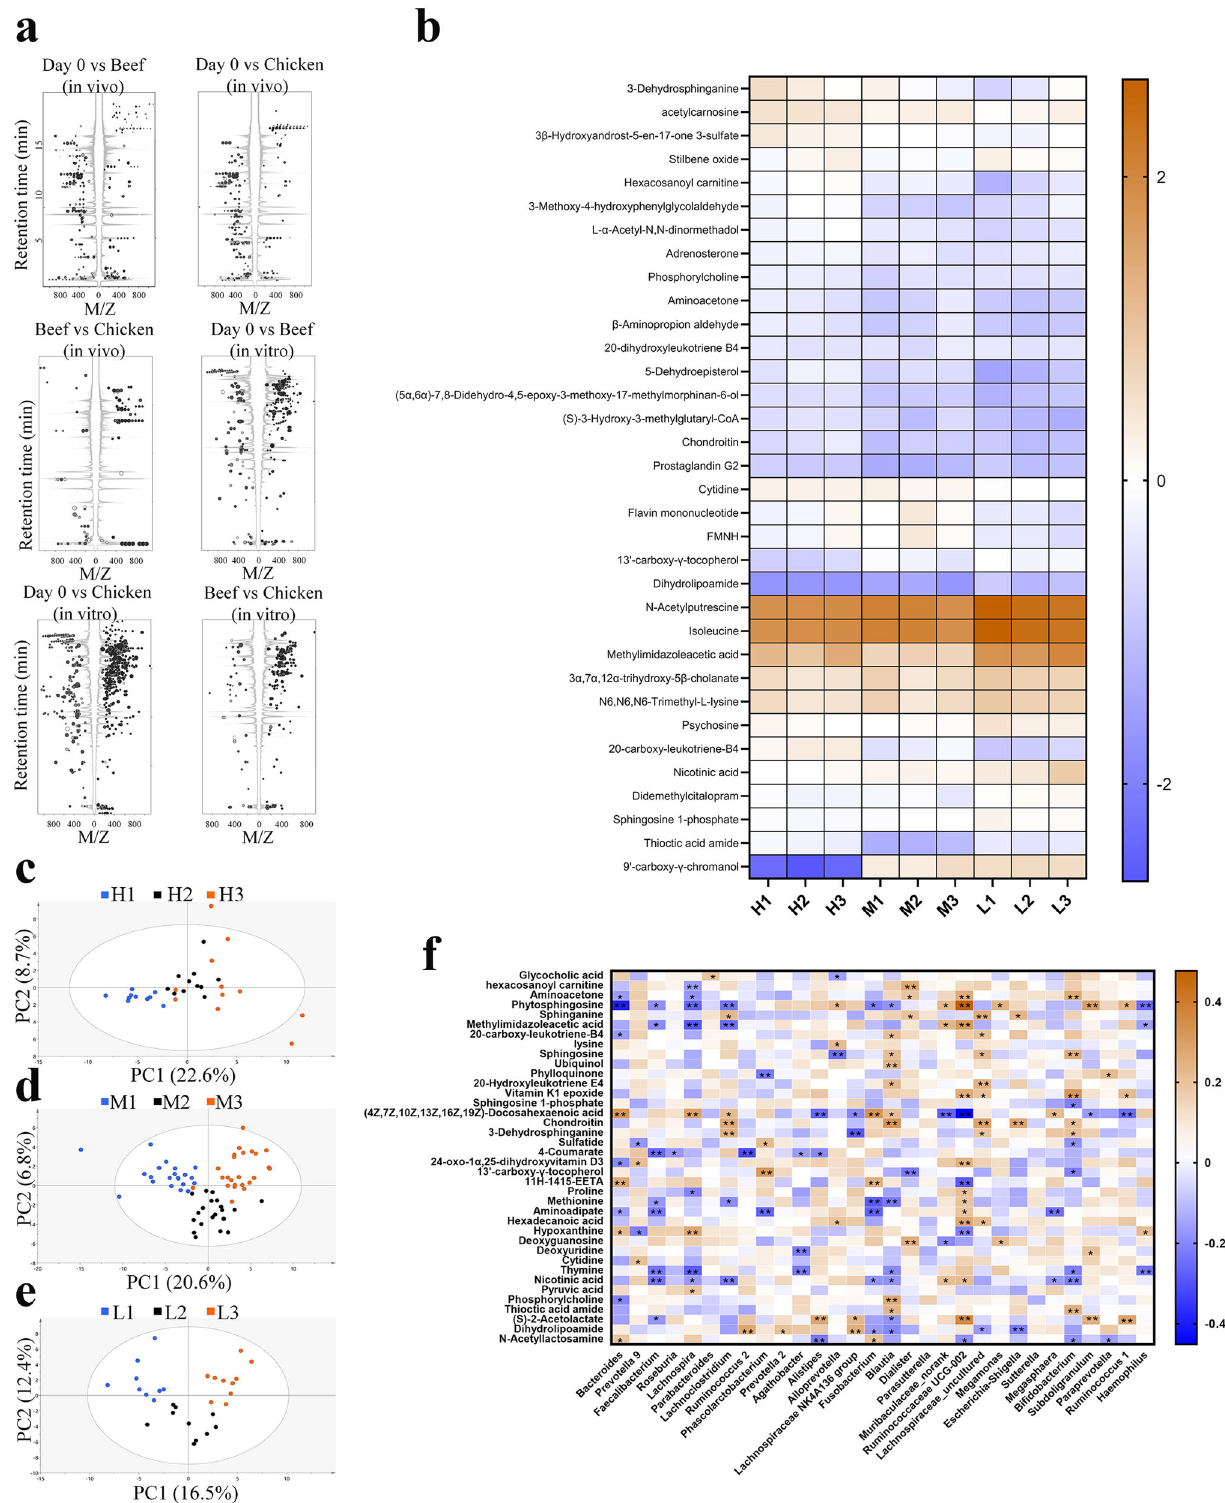
Fig. 4 Comparisons of fecal metabolites in response to meat-based diet alteration in the high-, middle- and low-BMI volunteers. a Cloud map analysis of the differential m/z ( P < 0.05); b Heatmap of fecal metabolites showed signi fi cant responses ( P < 0.05) to meat-based diet alterations, the color bar indicates the relative content of metabolites; c – e PCA score plots of the fecal metabolites in high- ( c ), middle- ( d ) and low-BMI volunteers ( e ); f Heatmap for correlation coef fi cients between the fecal metabolites and the fecal microbiota. * and ** indicate that coef fi cients are signi fi cant ( P < 0.05) and highly signi fi cant ( P < 0.01), respectively; the color bar indicates the Pearson ’ s correlation coef fi